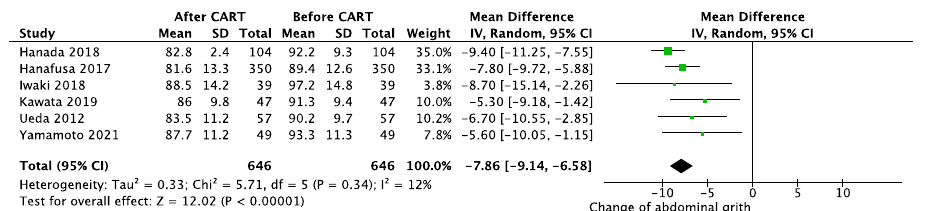
Figure 1. Change in body weight before and after CART.